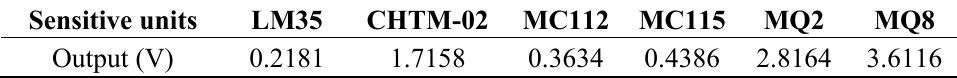
Table 7. Static outputs of 64th time point.